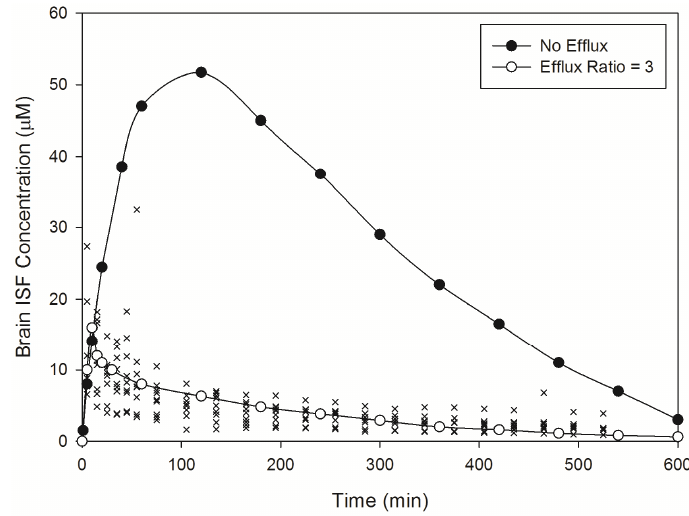
Figure 3. Model predicted norfloxacin brain concentrations in rats. Crosses represent literature reported brain concentration determined in rats following an IV-bolus dose [88]. Closed circles represent model predicted norfloxacin brain concentrations in rats in the absence of efflux. Open circles represent model predicted norfloxacin brain concentrations in rats in the presence of efflux (efflux ratio = 3).